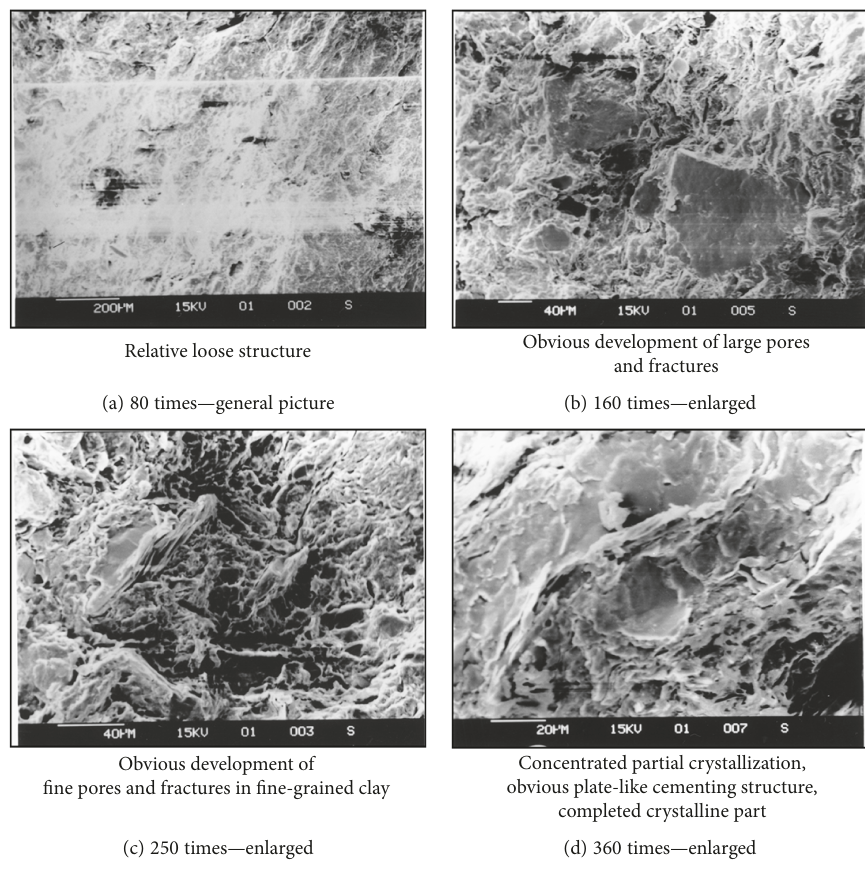
Figure 3: SEM images of the weathered coal gangue at di ff erent